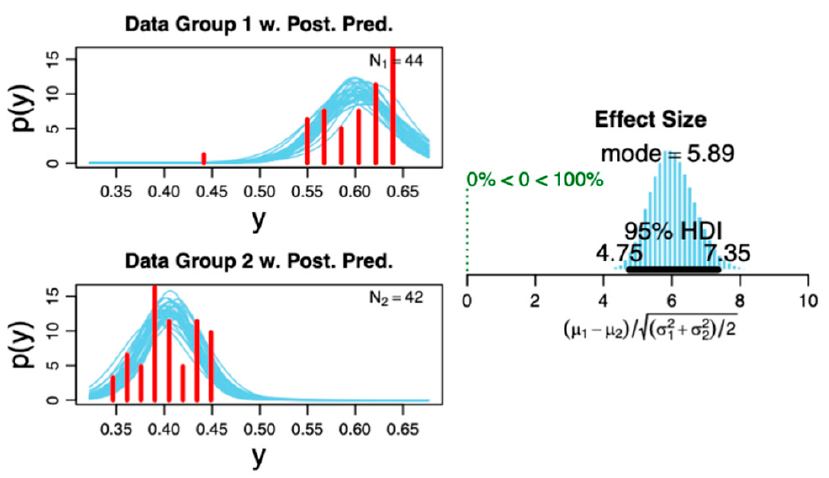
Figure 7. Posterior distribution of the studied groups. The plot on the right shows the distribution histogram of the effect size displaying the 95% high-density interval (HDI), which is within the analyzed data. This indicates a sufficient sample size of included subjects based on the primary outcome (i.e., phase–amplitude cross-frequency coupling for theta–gamma at the N1 sleep stage). The plots on the left show the probability distribution with superimposed posterior predictive distribution of raw data for each data sample. Please refer to Ref [43] for methodological details regarding the distributions.